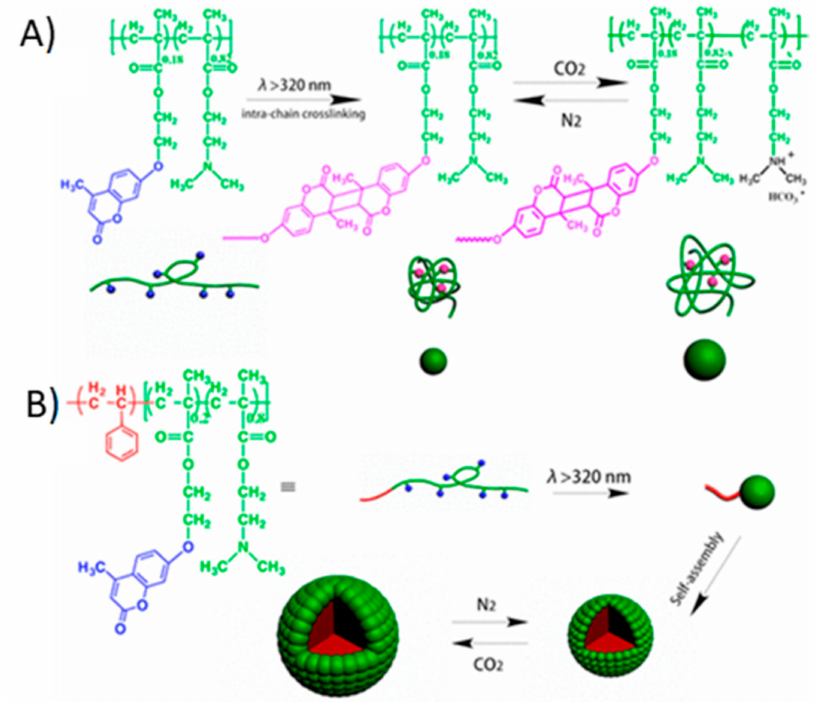
Figure 3. Schematic illustration of the synthesis via intrachain coumarin dimerization of: ( A ) CO 2 -responsive SCNPs, and ( B ) CO 2 -responsive micelles self-assembled from amphiphilic tadpole-shaped Janus SCNPs. Reprinted from [24] with